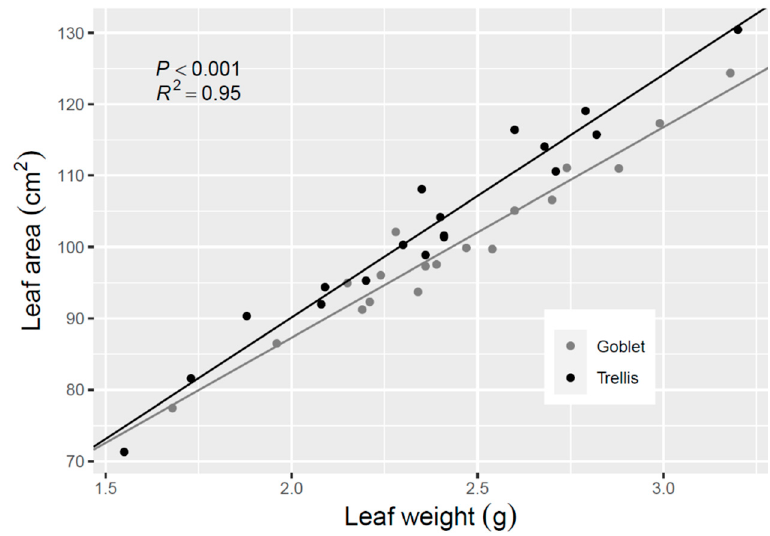
Figure 4. Relationship between leaf area and leaf weight for leaves collected from Xynisteri vines trained as either goblet or trellis. See text for results of statistical analyses.